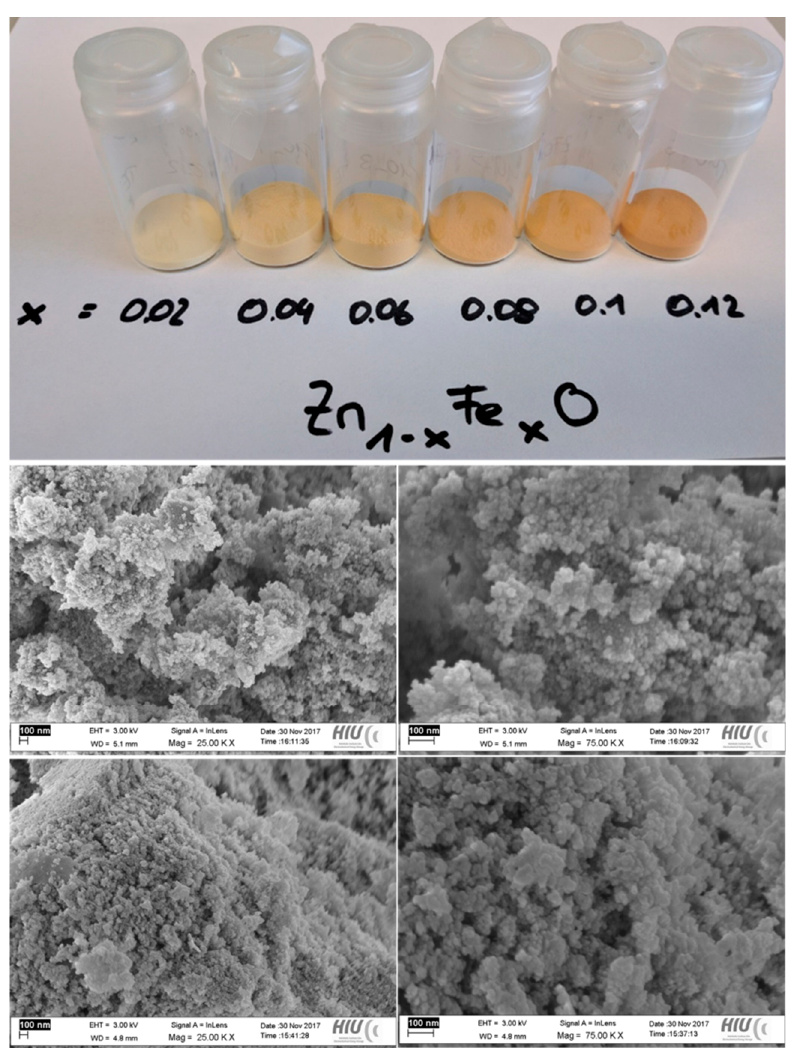
Figure A1. Top panel : Photograph of the Zn 1 − x Fe x O samples with x being 0.02, 0.04, 0.06, 0.08, 0.10, and 0.12. The photograph nicely illustrates the increasing orange coloring with an increasing Fe content. Lower panels : Scanning electron microscopy (SEM) micrographs of selected Zn 1 − x Fe x O samples with x being 0.12 ( middle left and right ) and 0.04 ( bottom left and right ).